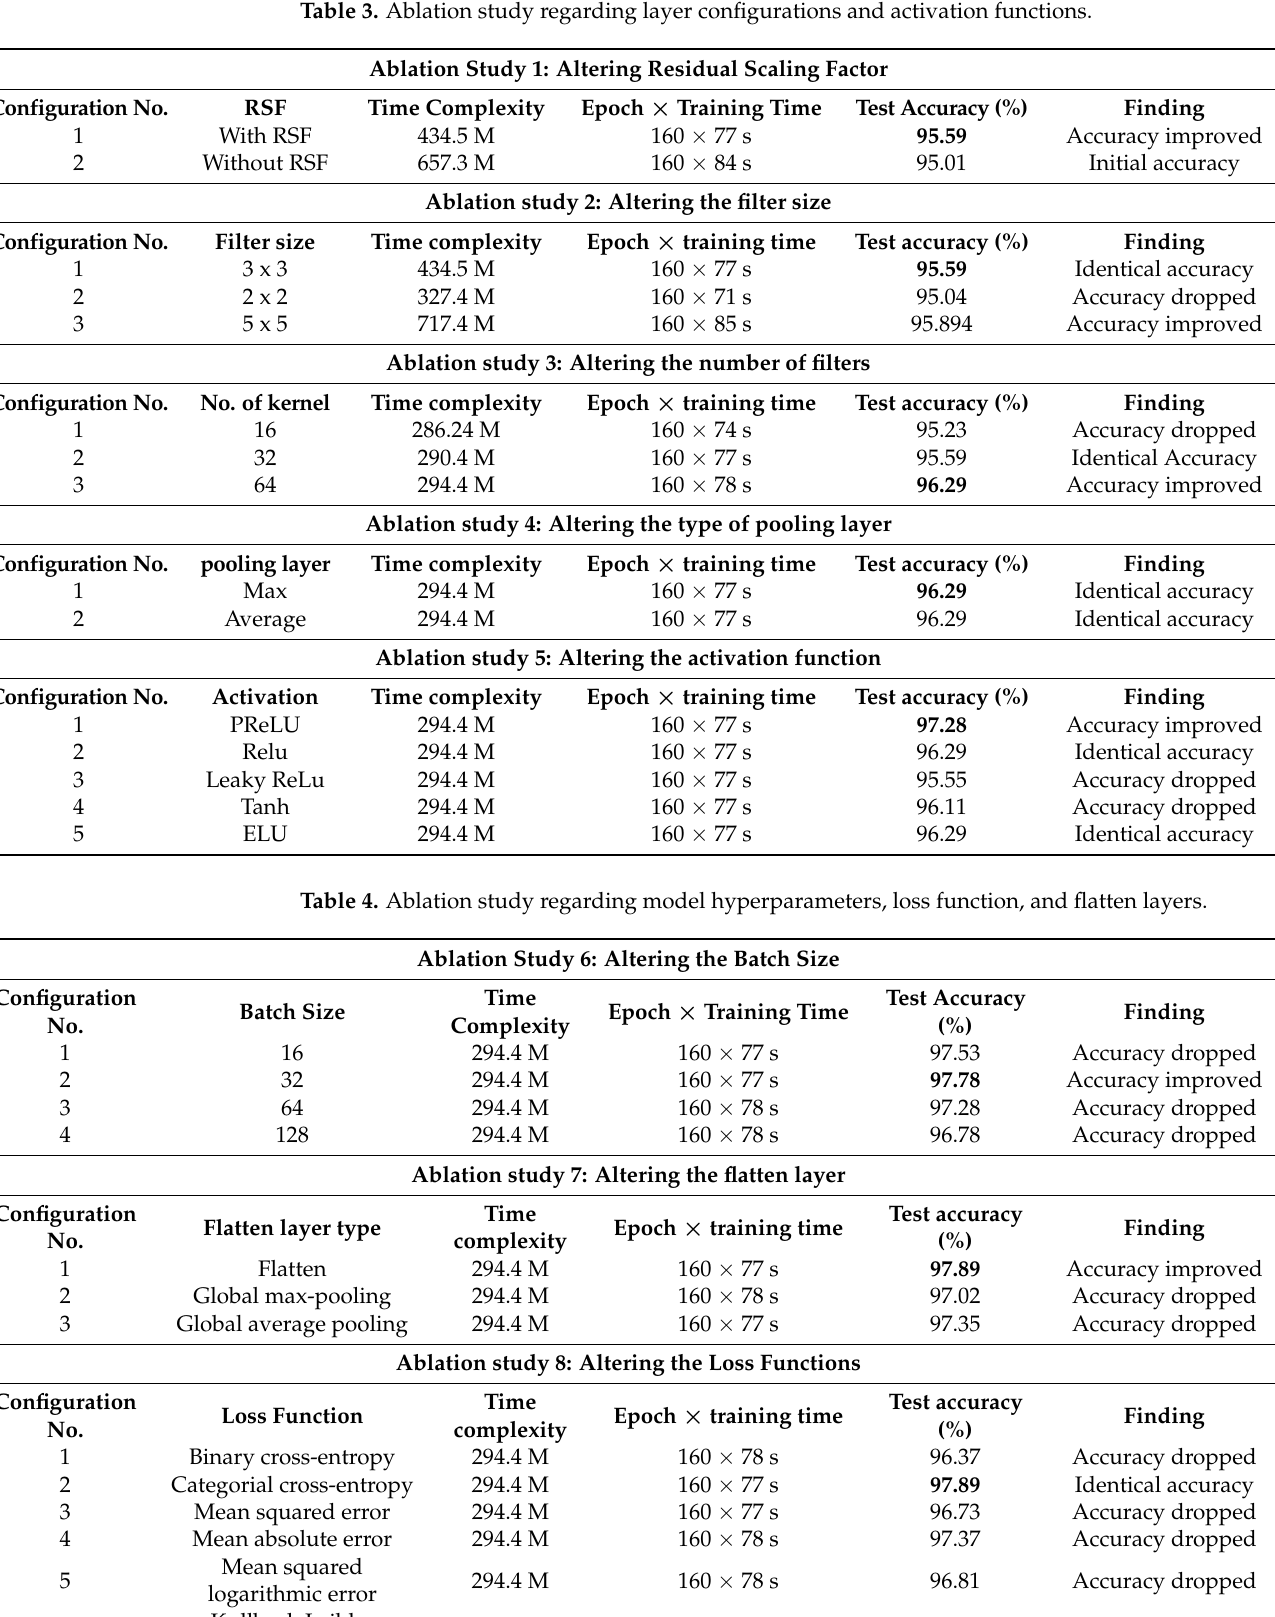
Table 3. Ablation study regarding layer configurations and activation functions.